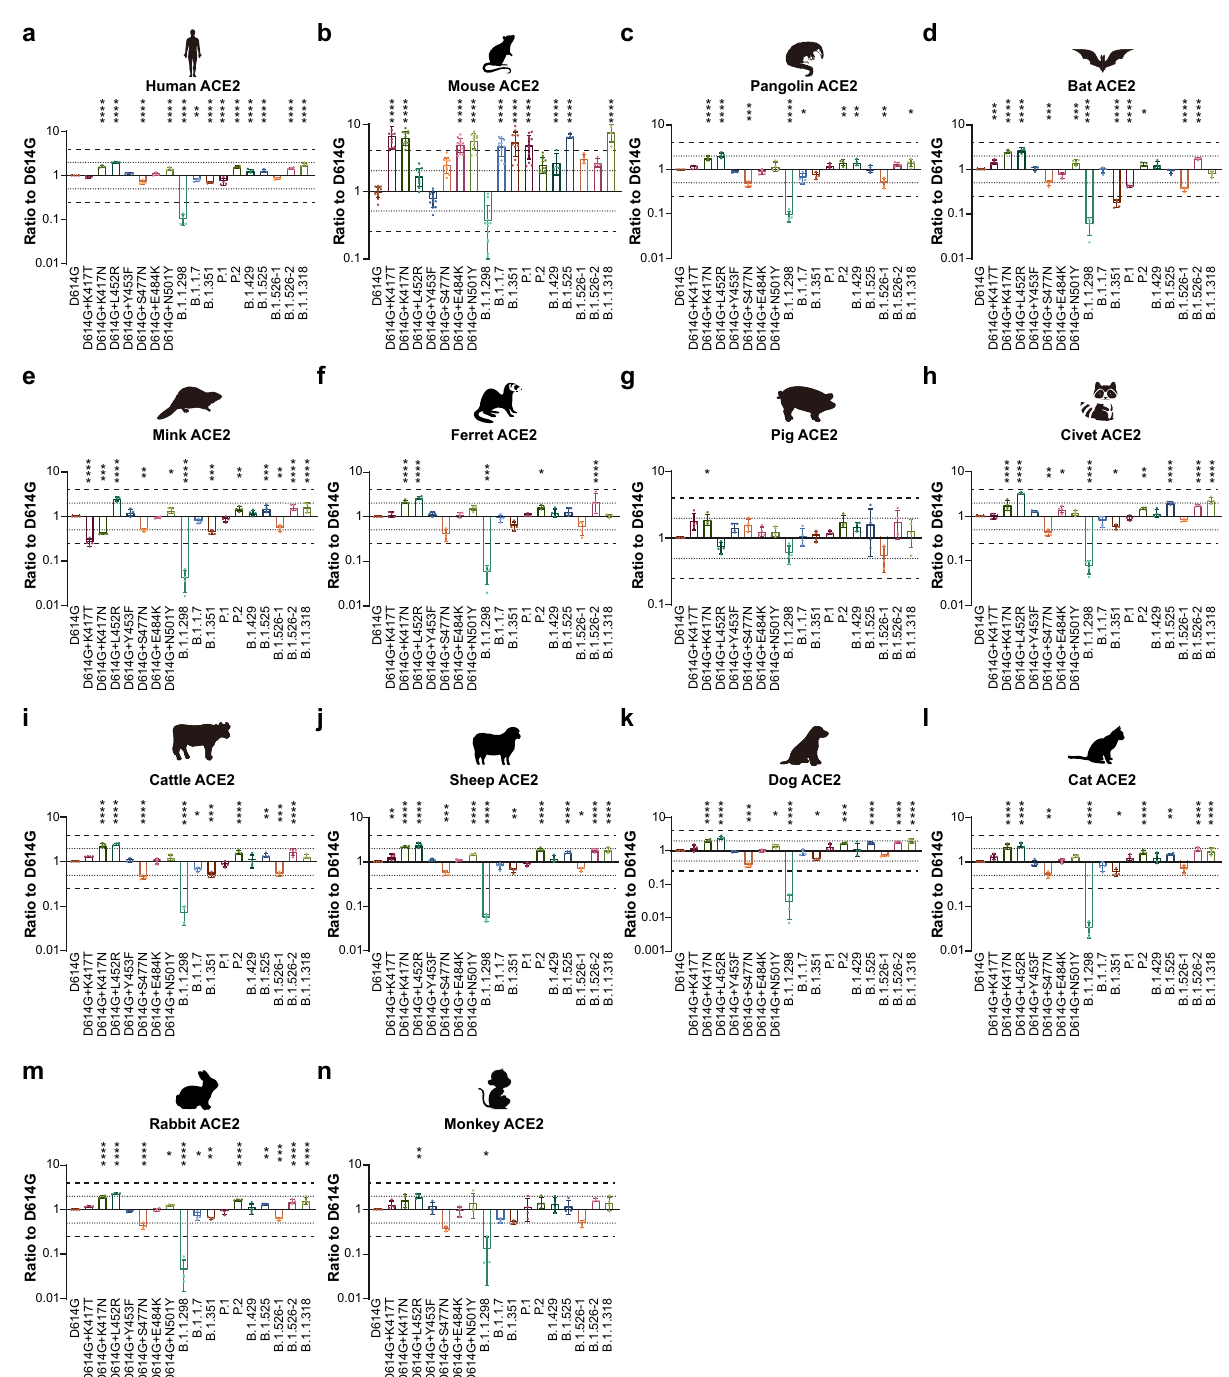
Fig. 3 Infectivities of SARS-CoV-2 Variants in cell lines expressing ACE2 proteins from 14 different species. Equal amounts of overexpression plasmids carrying ACE2 sequences from different species were transfected into 293 T cells. Transfection ef fi ciency was con fi rmed by fl ow cytometry analysis of ACE2 surface expression. Cells were then infected with the same copy number of SARS-CoV-2 variants after quanti fi cation. Chemiluminescence signals were collected 24 h later. Ratios between variants and the D614G reference strain were calculated. The results were obtained from four independent experiments and the values shown indicate means ± SEMs. a human; b mouse; c pangolin; d bat; e mink; f ferret; g pig; h civet; i cattle; j sheep; k dog; l cat; m rabbit; n monkey. Dashed/dotted lines indicate the threshold of fourfold/twofold difference. Asterisks indicate statistical signi fi